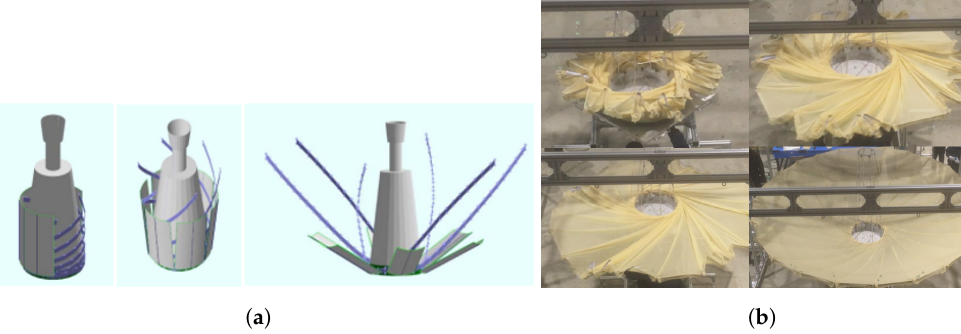
Figure 6. Conceptual mechanism of wrap-rib deployment and deployment test of wrap-rib